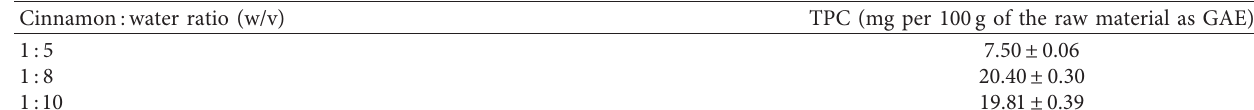
Table 1: Total polyphenol content of cinnamon extracted in different ratios of water.